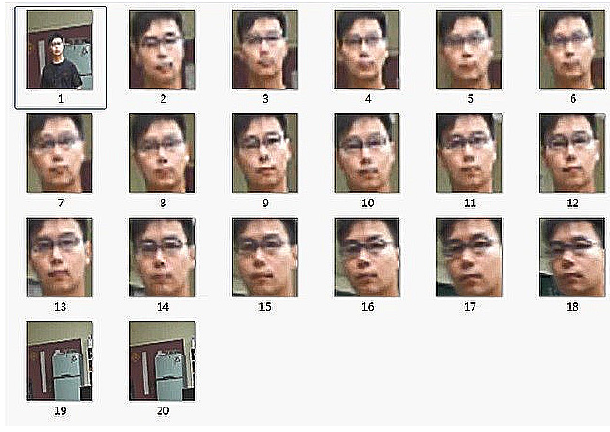
Figure A2. Real-time face detection pictures.